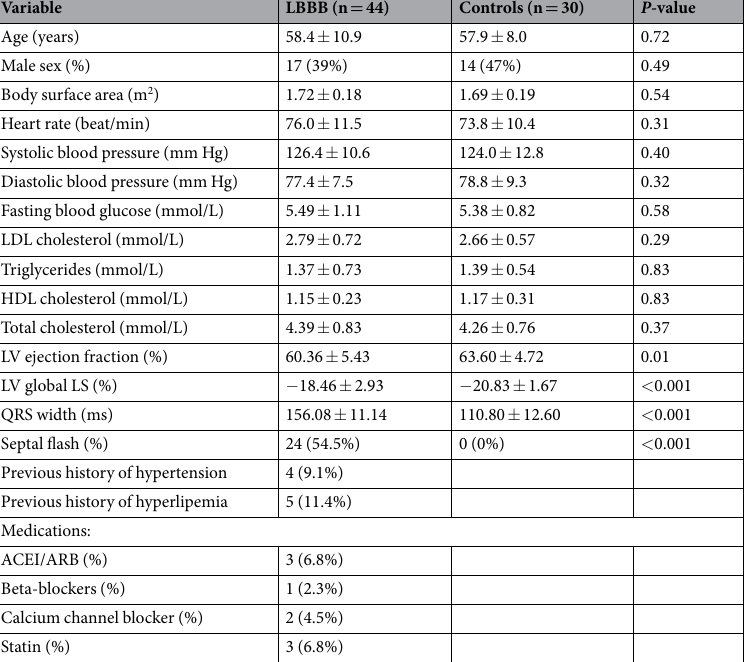
Table 1. Baseline characteristics of the study population. Values shown are Mean ± SD or percentage. LV, left ventricle; LDL, low-density lipoprotein; HDL, high-density lipoprotein; LS, peak systolic longitudinal strain; ACEI, angiotensin-converting enzyme inhibitor; ARB, angiotensin II receptor blocker.